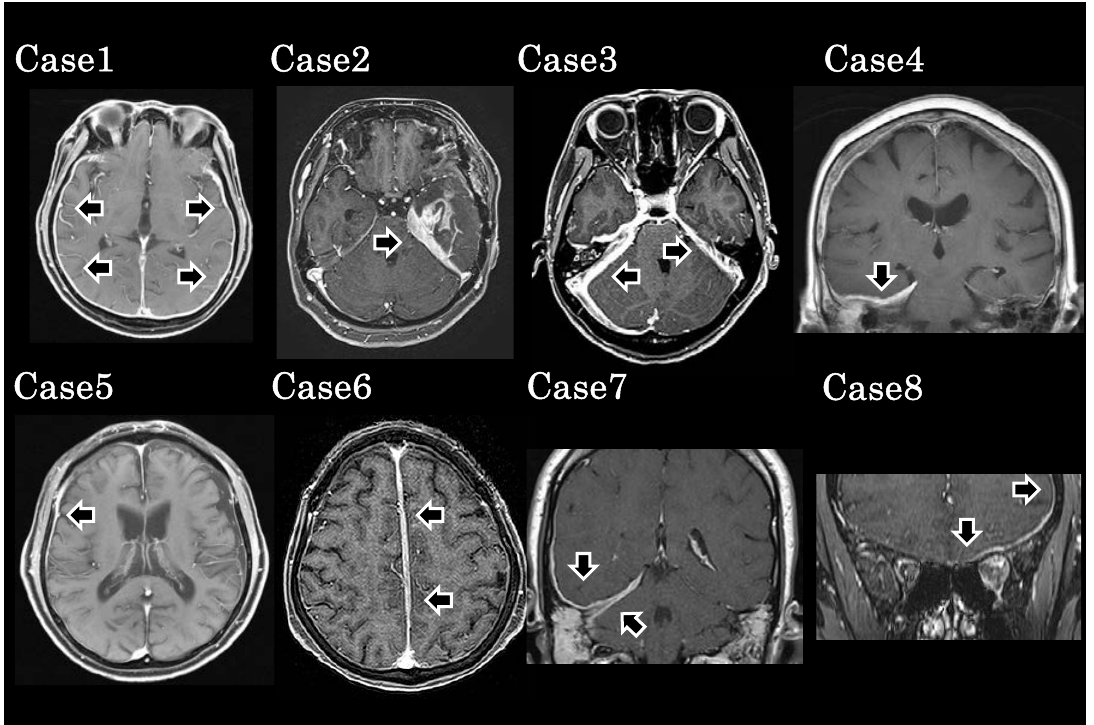
Figure 1 Magnetic resonance imaging findings on gadolinium-enhanced T1-weighted images of our eight patients with acute phase hypertrophic